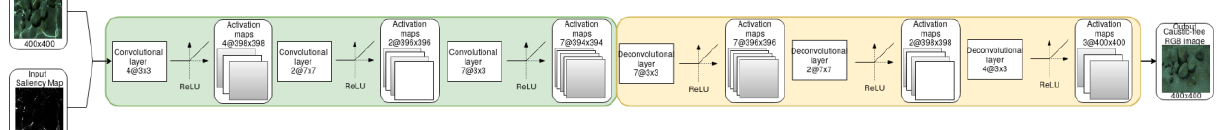
Figure 2. DeepCaustics: a 6-layer CNN consisting of 3 convolutional layers followed by 3 deconvolutional layers. A ReLU activation unit follows each [de-]convolution